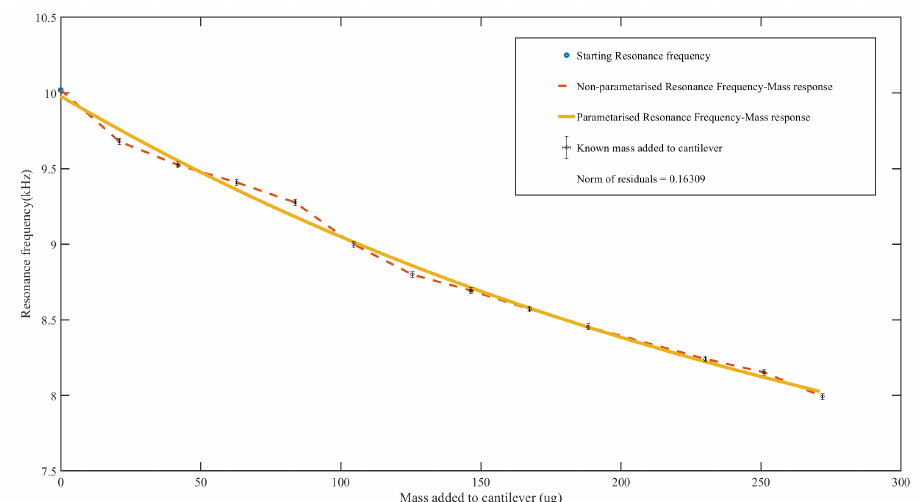
Figure 6. Parameterized resonance frequency to the added mass response calibration set-1 using generic masses.